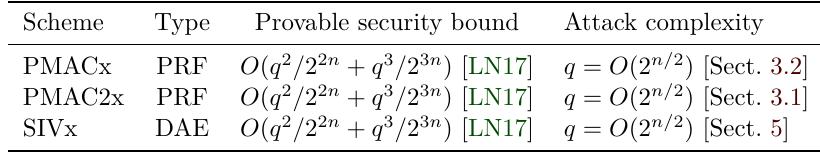
Table 1: Summary of our results. In the table, n is the block length of the underlying TBC and q is the number of queries. The attacks against PMACx and PMAC2x are distinguishing attacks. We have both distinguishing and forgery attacks against